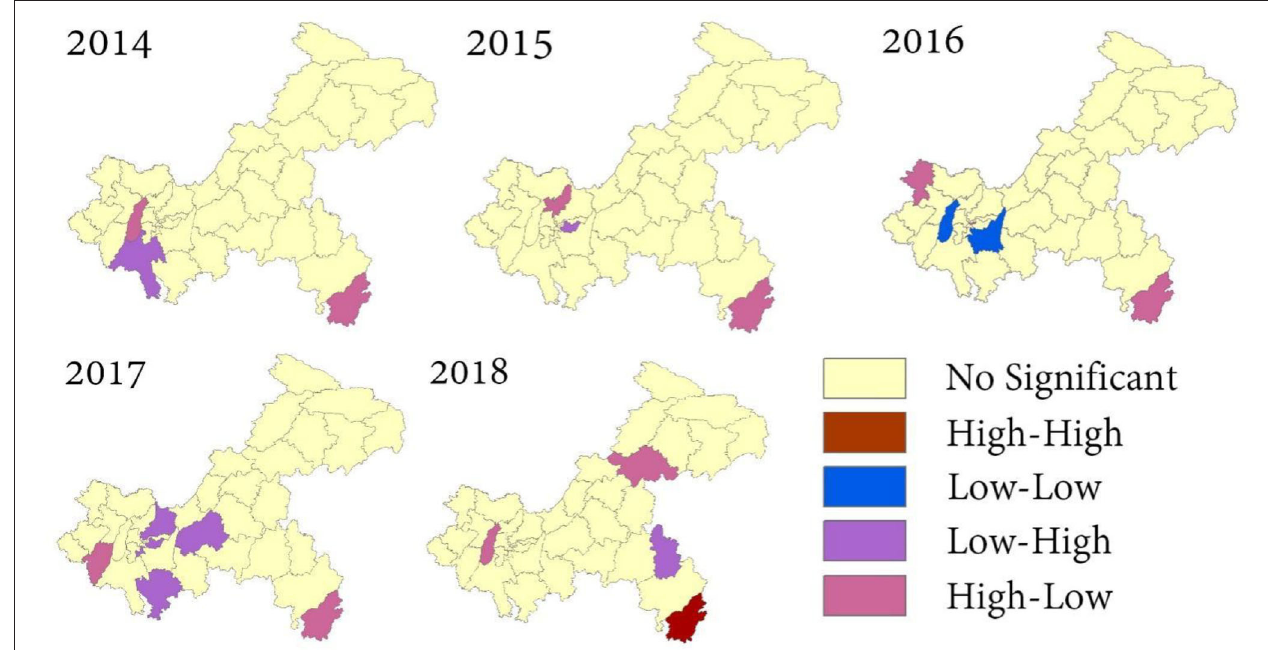
FIGURE 5 | Local spatial autocorrelation of influenza in Chongqing.